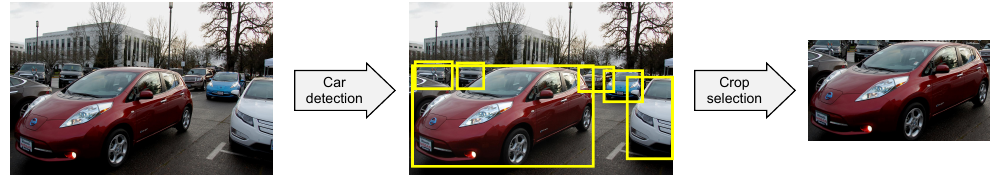
Figure 4. Car-tight bounding box annotation pipeline. Original image “Clean cars” by OregonDOT is licensed with CC BY